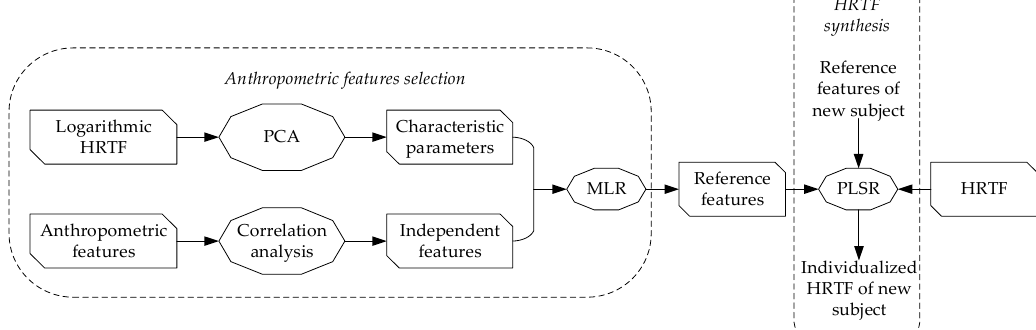
Figure 4. Schematic diagram of the integrated head-related transfer functions (HRTF) individualization method. MLR: Multiple Linear Regression; PCA: Principle Component Analysis.